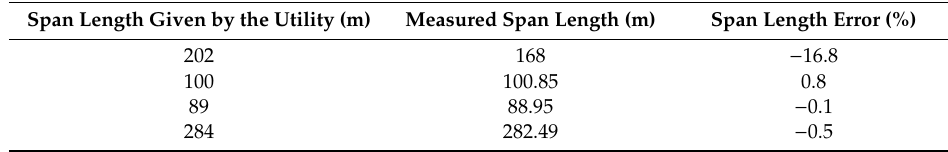
Table 3. Measured span